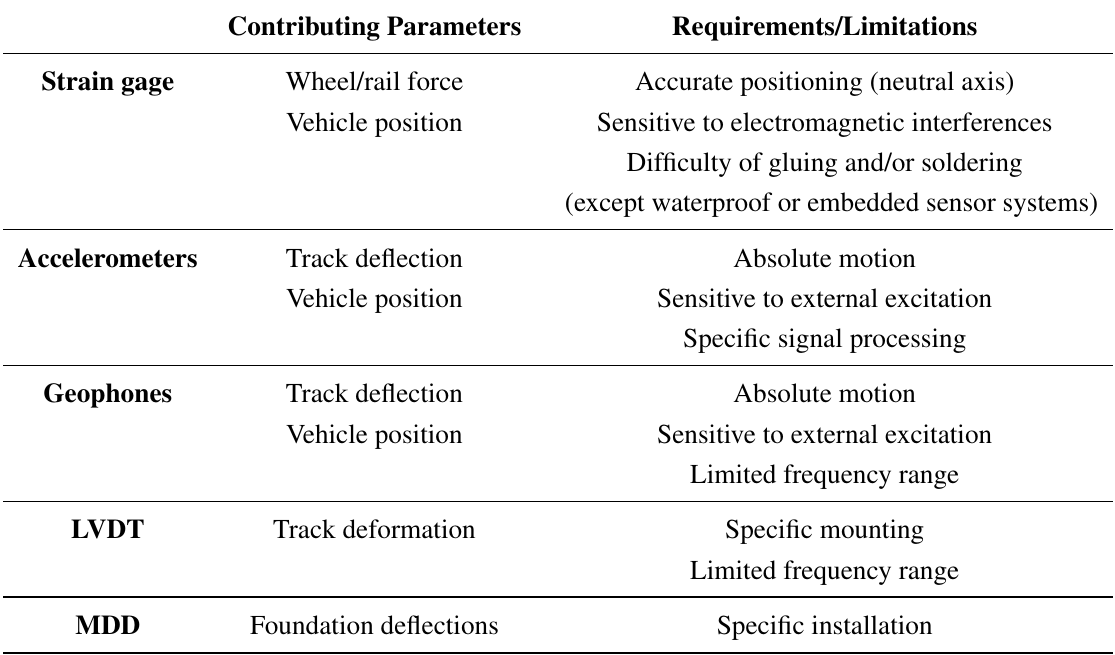
Table 1. Performances of typical transducers for railway